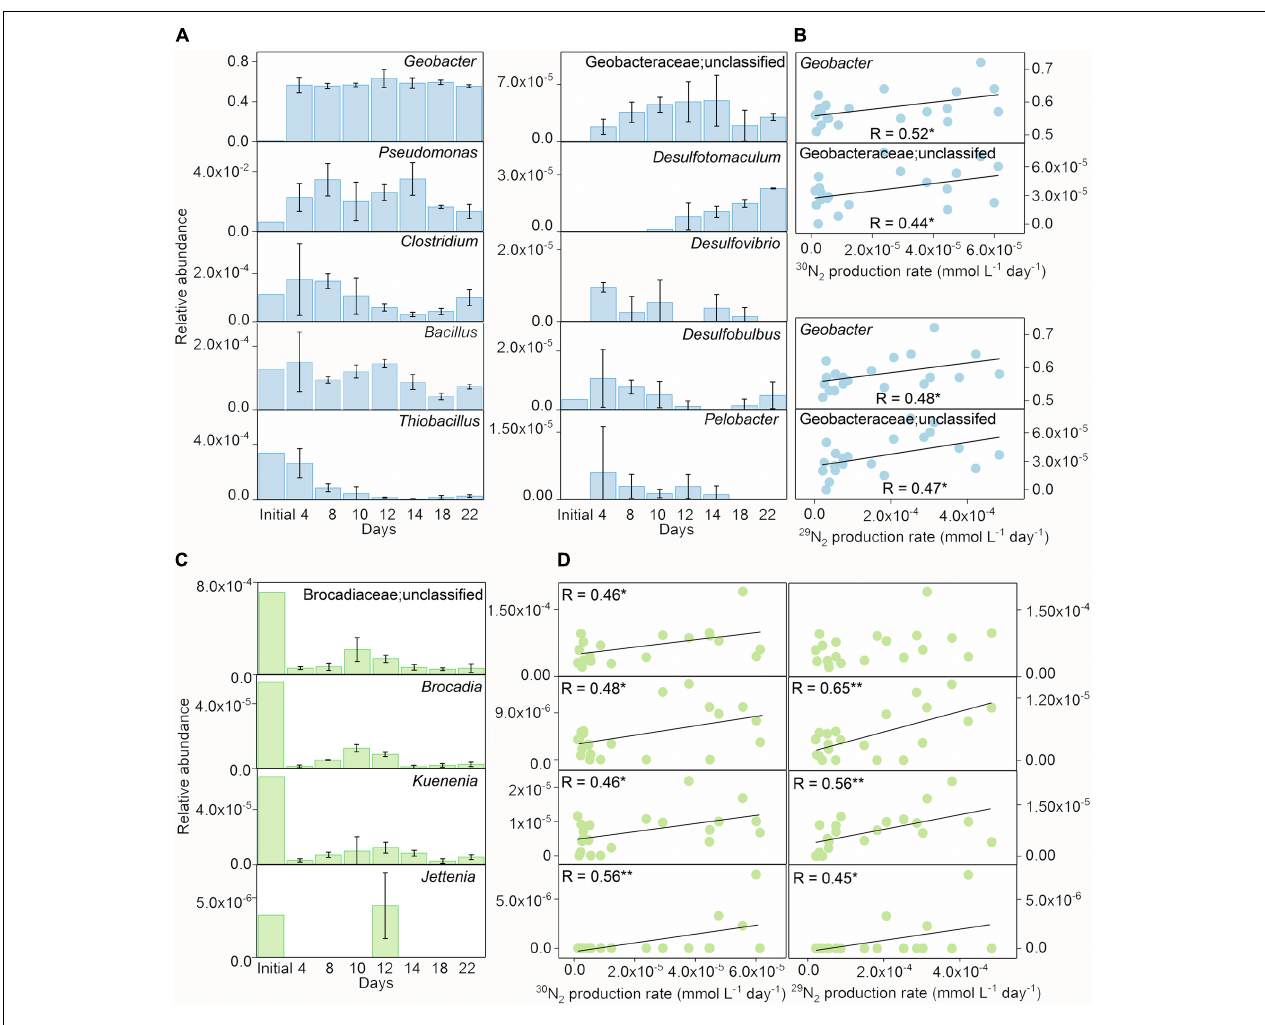
FIGURE 4 | The relative abundances of iron(III) reducers and Anammox bacteria during incubation. The relative abundances of iron(III) reducers (A) and the correlation between the relative abundances of Geobacter /unclassified Geobacteraceae and 15 N 2 production rates (B) in the inoculant-based treatment of Fe(III) + NH 4 + during 22-day incubation. Error bars represent standard deviations of three replications. The relative abundances of Brocadiaceae (unclassified), Brocadia , Kuenenia , and Jettenia (C) , and the correlation between the relative abundance of Geobacter and 15 N 2 production rates (D) in the inoculant-based treatment of Fe(III) + NH 4 + . Error bars represent standard deviations of three replication. “*” and “**” represent a statistically significant relationship between relative abundances of iron(III) reducers, Anammox bacteria, and 15 N 2 production, which is denoted at p < 0.05 and p < 0.01,